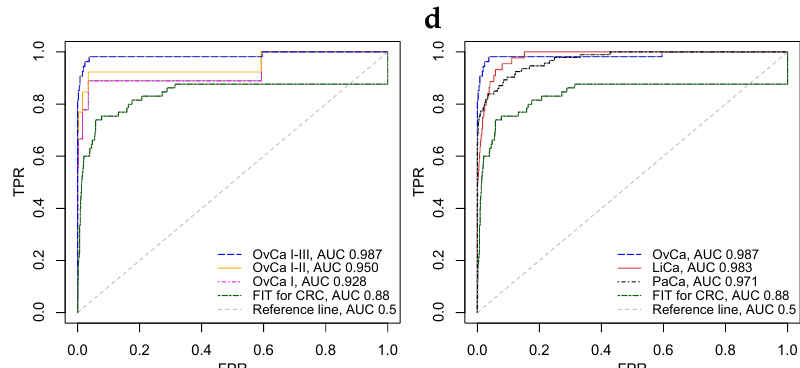
Figure 4. Biomarkers for the detection of ovarian, liver, and pancreatic cancers, that are superior vis-à-vis benchmark predicate device FIT at the 99% significance level. ( a ) Scatter plot of CancerSeek data, CA-125 and Prolactin, per OvCa stage (I, II and III) and female healthy controls. ( b ) Scatter plot similar to Subfigure ( a ), with cut-offs at 4.5 and 10.3; illustrating positive and negative classification regions. ( c ) ROC-curves for CA-125 and Prolactin as a biomarker for the detection of OvCa, per stages. Stronger biomarker signals for more advanced cancers are evident. For reference, FIT for CRC and the diagonal line is included. ( d ) ROC-curves for biomarkers for detection of OvCa (CA-125, Prolactin), LiCa (HGF, Osteopontin) and PaCa (CA 19-9, sErbB2). FIT and the diagonal line included for reference.